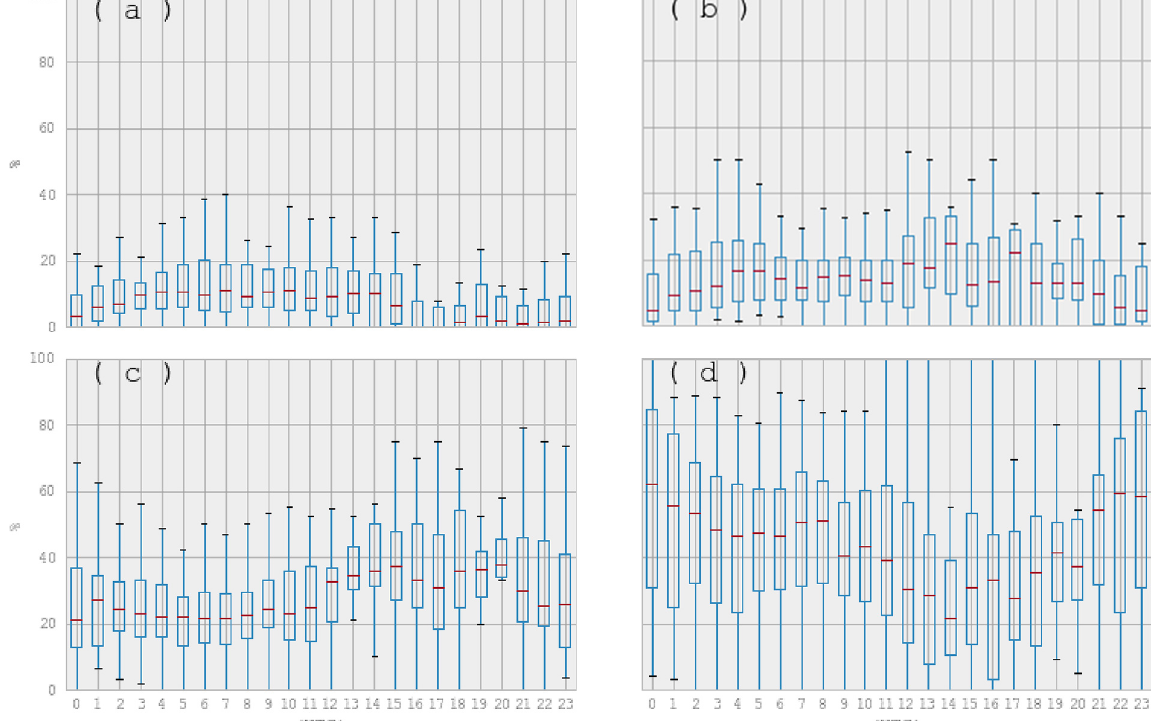
Fig. 3. Box plot diagram of visibility frequencies in a day from 42 airports with periods from July to December 2015. The impact of smoke is quantified based on visibility values (Table 1) dividing into 4 classes: H1 (VFR) (a), H2 (SVFR) (b), H3 (IFR) (c), H4 (LIFR) (d). H1: smoke with visibility > 4.8 km; H2: smoke with visibility 3.2–4.8 km; H3: smoke with visibility 1.6–3.2 km; while H4: smoke with visibility <1.6